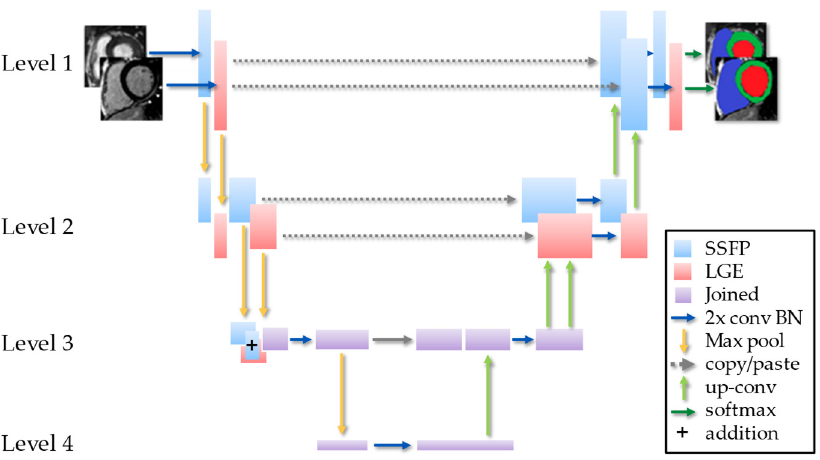
Figure 2. Schematic of the MI-UNet with 2 convolutions and batch normalization (2x conv BN). The shared hidden layer that produced the optimal number of shared layers was identified. When the hidden layers were shared prior to the deepest layer, the subsequent layers acted as a single-input UNet. The final results of the two streams were not fused. Rather, the two streams shared a common deep embedding with separate encoders and decoders. This was to promote shared embedding between two spatially co-located imaging sources.